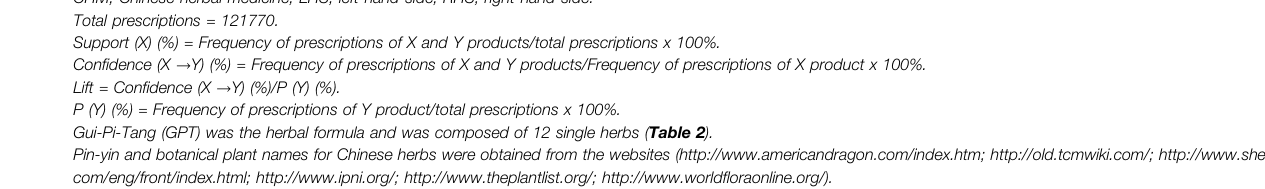
Gui-Pi-Tang (GPT) was the herbal formula and was composed of 12 single herbs ( Table 2 ). Pin-yin and botanical plant names for Chinese herbs were obtained from the websites (http://www.americandragon.com/index.htm; http://old.tcmwiki.com/;